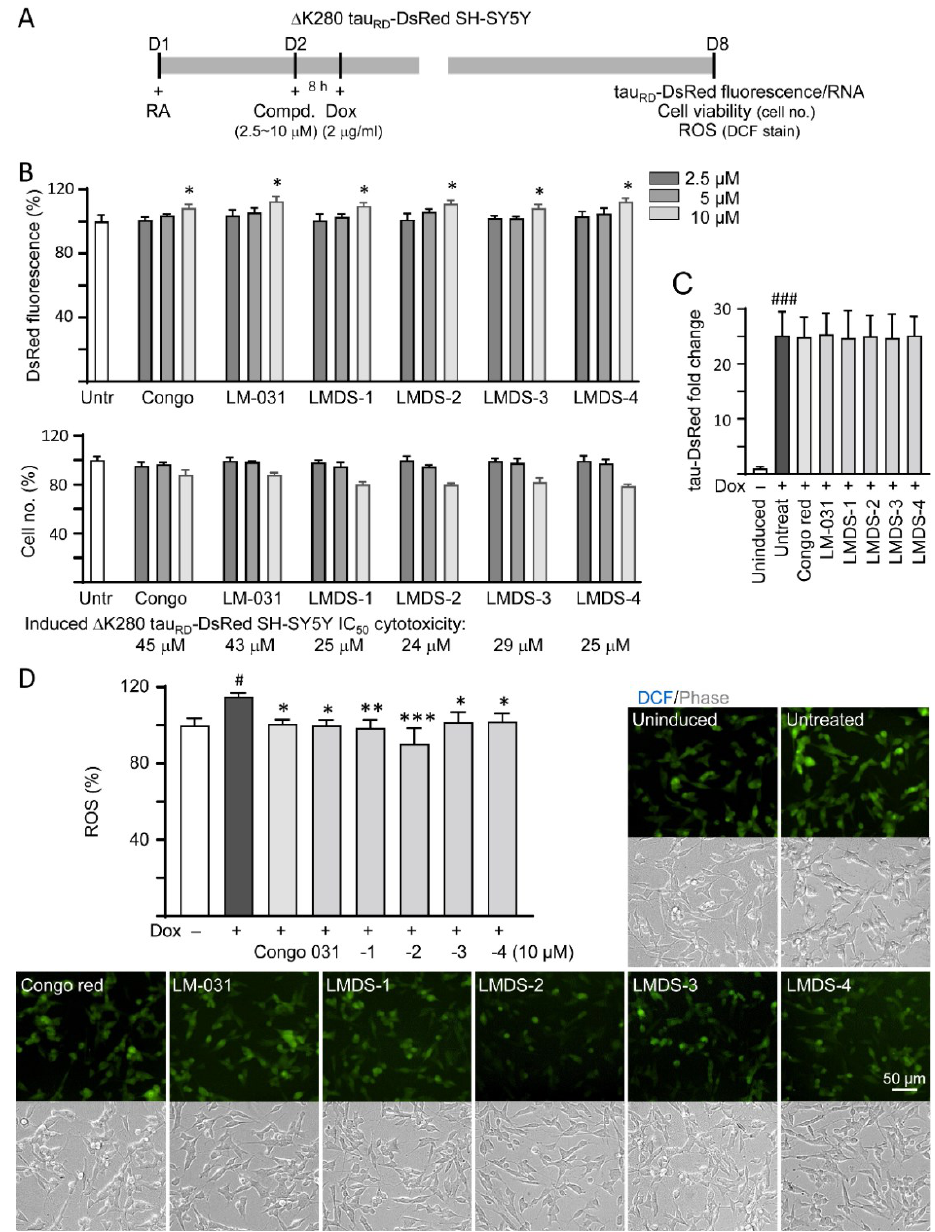
Figure 2. Cellular ΔK280 tau RD aggregation and oxidative stress inhibitory effects of coumarin compounds in ΔK280 tau RD -DsRed SH-SY5Y cells. ( A ) Experimental flow chart. On day 1, cells were plated with retinoic acid (RA, 10 µM) added to the culture medium. On day 2, Congo red, LM-031 or LMDS-1 to -4 (2.5 – 10 µM) was added to the cells for 8 h, followed by inducing ΔK280 tau RD -DsRed expression with doxycycline (Dox, 2 µg/mL) for 6 days. On day 8, ΔK280 tau RD -DsRed fluorescence, tau RD -DsRed RNA and ROS (DCF stain) were measured. ( B ) Assessment of DsRed fluorescence with Congo red, LM-031 or LMDS-1 to -4 (2.5 – 10 µM) treatment ( n = 3). Shown below are cell number analyzed in each treatment. The relative DsRed fluorescence/cell number of untreated cells (Untr) was normalized as 100% (two-tai led Student’s t -test; *: p < 0.05). ( C ) tau RD -DsRed RNA of ΔK280 tau RD -DsRed cells untreated or treated with Congo red, LM-031 or LMDS-1 to -4 at 10 µM